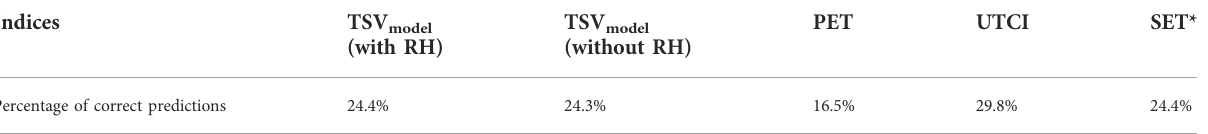
TABLE 7 Percentage of indices ’ correct